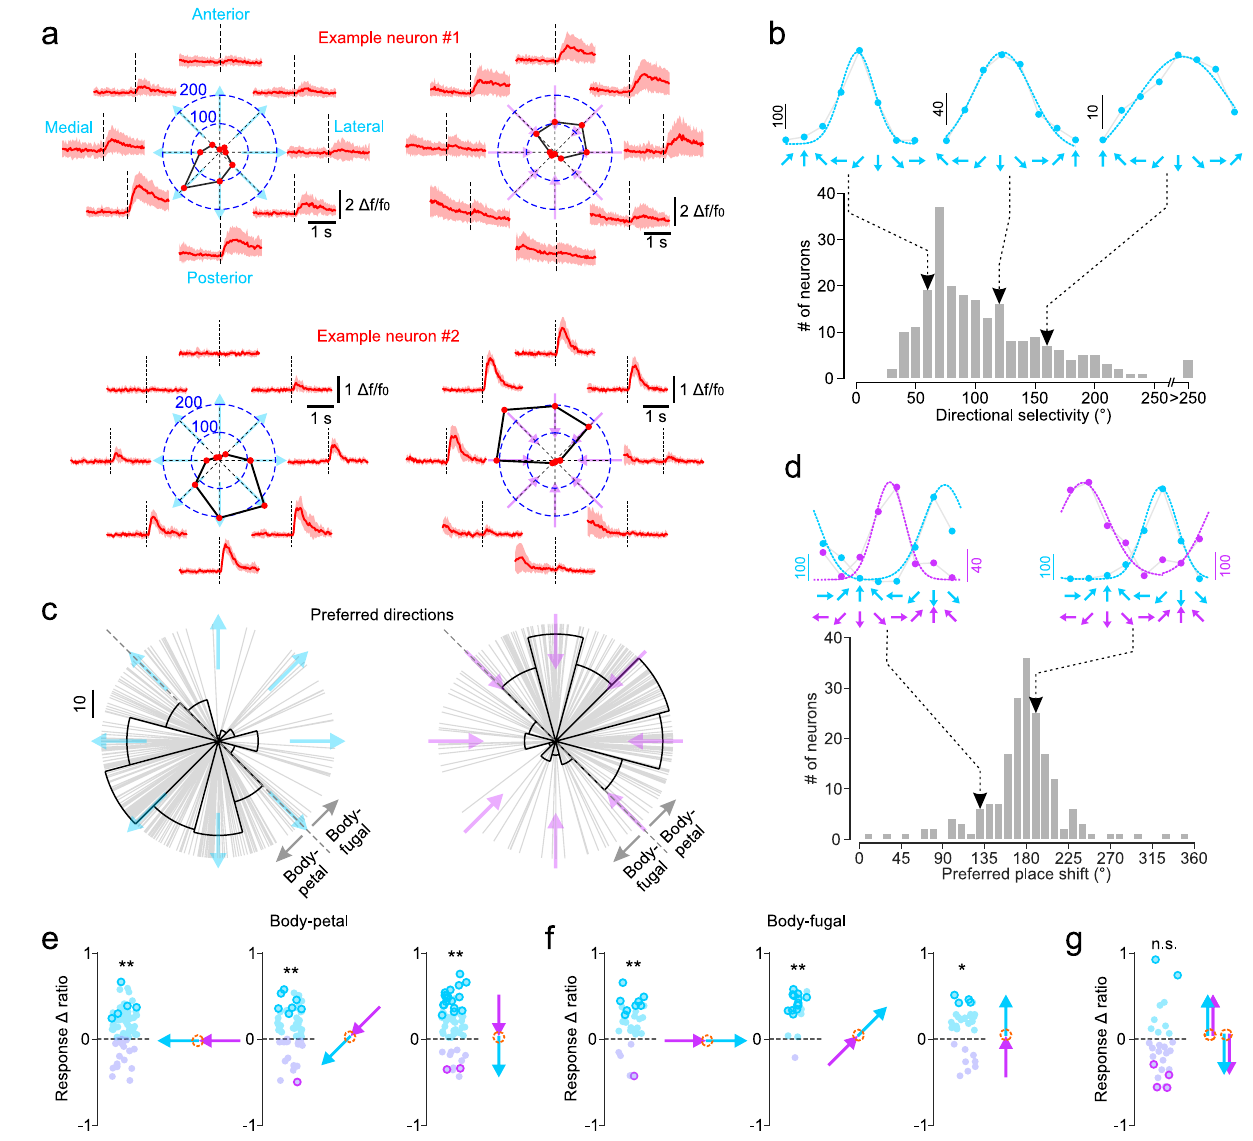
Fig. 6 | Selective tuning of fS1 neurons to the direction of passive forelimb movement reveal a peripersonal representation of proprioception. a Two example neurons with different preferred directions. Red traces: mean (±s.d.) responsestoeightdifferentdirectionsofhome-to-targetmovements(cyanarrows) andtarget-to-homemovements(magentaarrows)withthesameamplitude(7mm) andvelocity(2cm/s).Polarplots:peakactivity(deconvolvedspikerate)asfunction of movement direction (red circles and numerical values refer to peak spike rate). Dotted lines: movement onset b Top, Gaussian fi ts (dotted lines) to directionally tunedpeakresponses(deconvolvedspikerate)ofthreeexampleneurons.Bottom, distribution of directional selectivity (width of the Gaussian fi ts, measured in azi- muth angles of the earth ’ s horizontal plane) for home-to-target movements ( N =226 neurons, 18 mice). c Distribution of preferred directions for home-to- target movements (cyan arrows, N =226 neurons) and target-to-home movements (magenta arrows, N =197 neurons) indicates a preferred representation of body-